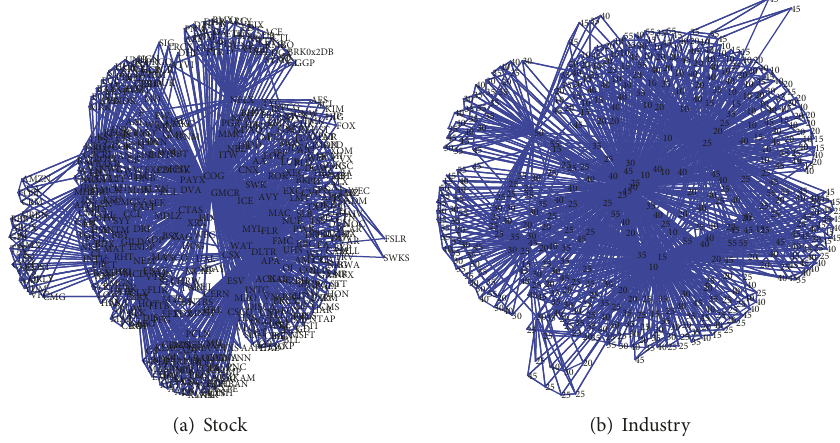
Figure 18: S&P468 PMFG. We label the vertices with stock codes in (a) and industry codes in